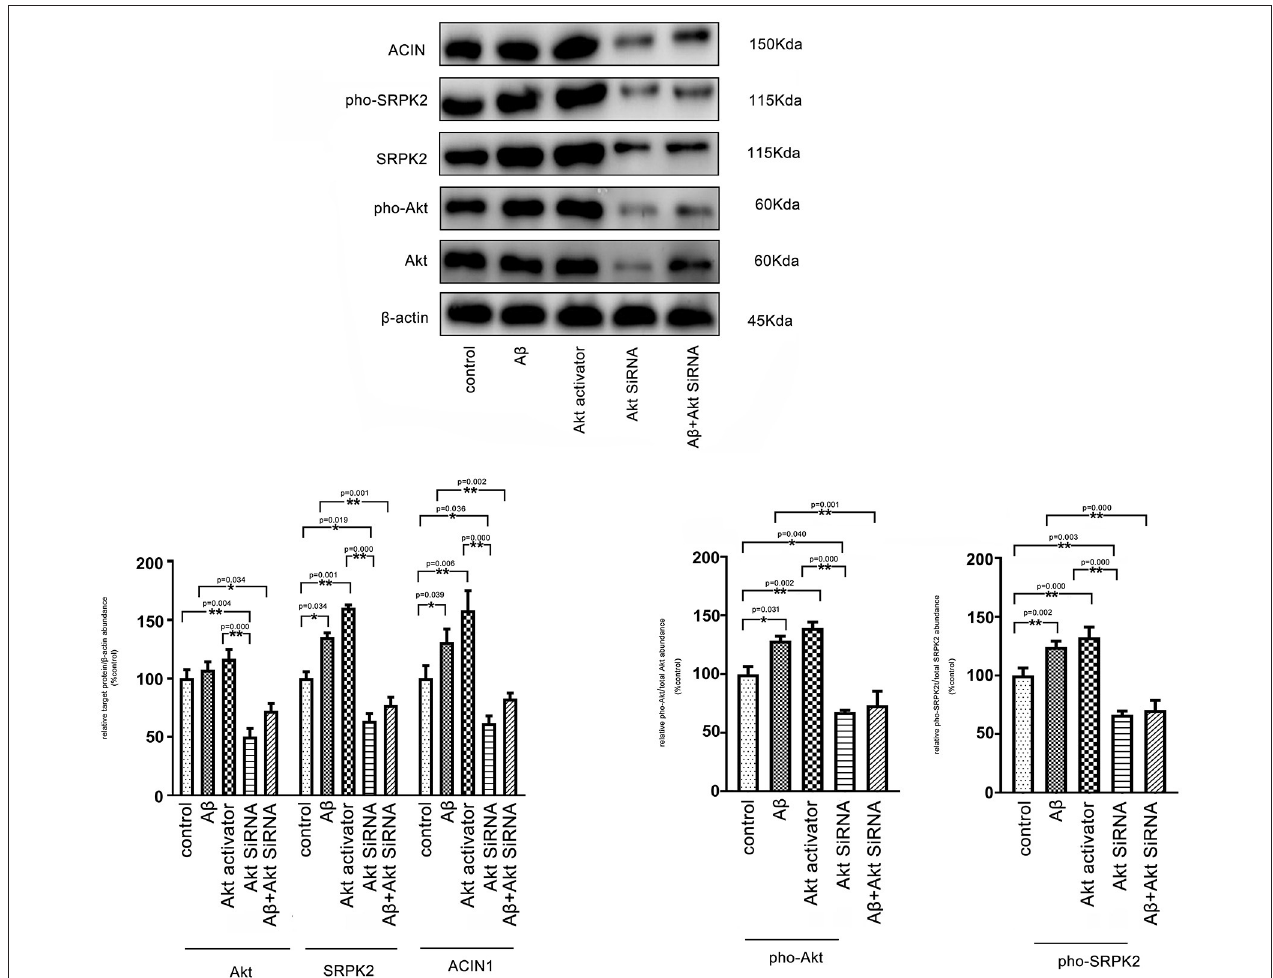
FIGURE 7 | A β regulates SRPK2 expression through the Akt pathway. The BV2 cells were treated with Akt activator or A β for 24h in vitro and SRPK2 expression was measured by western blot. The results showed that both the A β and Akt activator can increase the expression of SRPK2 level and phosphated SRPK2 level and ACIN1 level. However, when the expression of Akt was knockdown by siRNA in the BV2 cells, the regulatory effect of A β on the expression of SRPK2 and its related pathway was abolished including the expression of SRPK2 level and phosphated SRPK2 level and ACIN1 level. All the results were representative of three independent experiments performed in triplicate. The data were shown as the mean ± SEM (* p < 0.05; ** p < 0.01 by the one-way ANOVA). Akt siRNA, knockdown of Akt by siRNA; pho-Akt, phosphated Akt; pho-SRPK2, phosphated